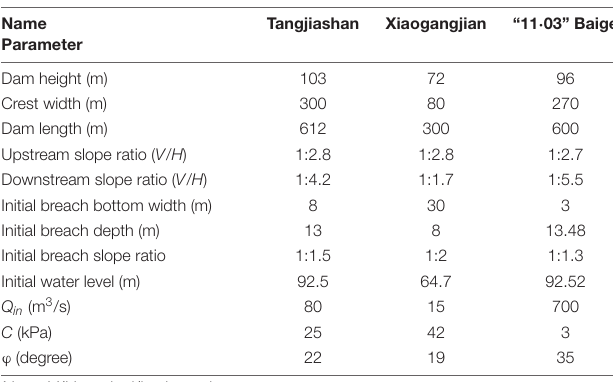
TABLE 4 | Parameters to be entered into the